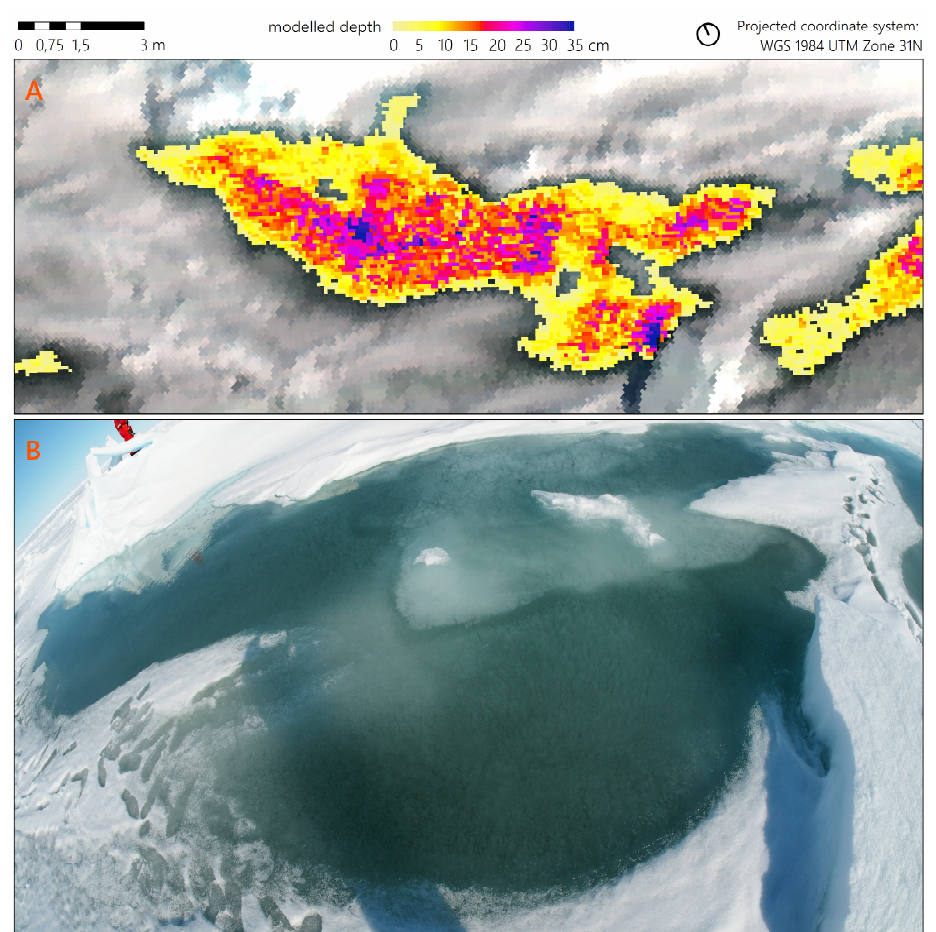
Figure 12. Comparison of bathymetry and field photograph. ( A ) Results of pond depth model applied to Empirical Line Correction results. Background: AisaEAGLE flight stripe (spatial resolution: 8.5 cm, RGB: 661.16 nm, 550.25 nm, and 482.57 nm). ( B ) Photo: Peter